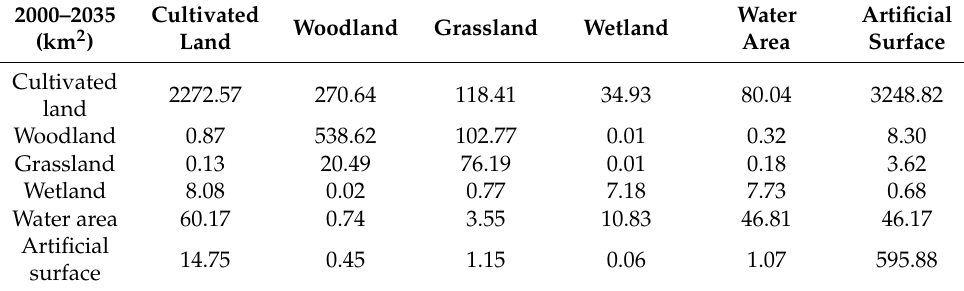
Table 6. Land use transfer matrix from 2000 to 2035.